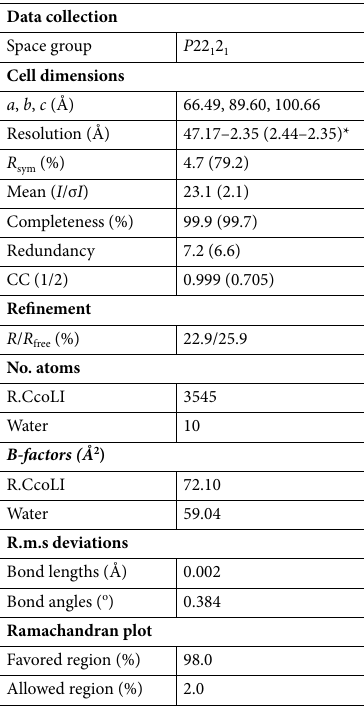
Table 1. Summary of data collection and refinement statistics of R.CcoLI. *The numbers in parentheses represent data for the highest-resolution